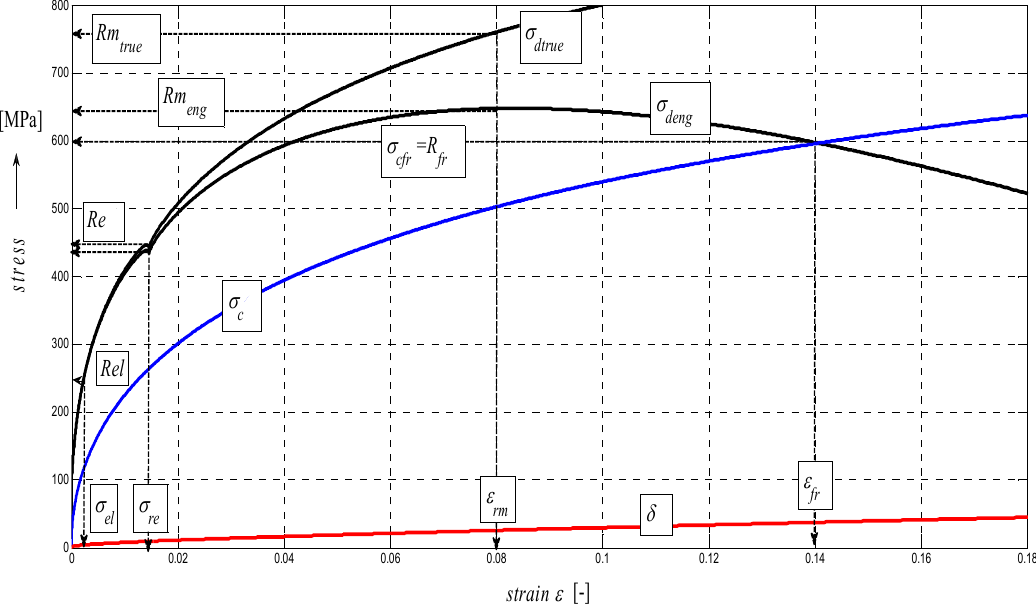
Figure 12. Diagram for ENS355J0 steel, dependence of functions on relative elongation.